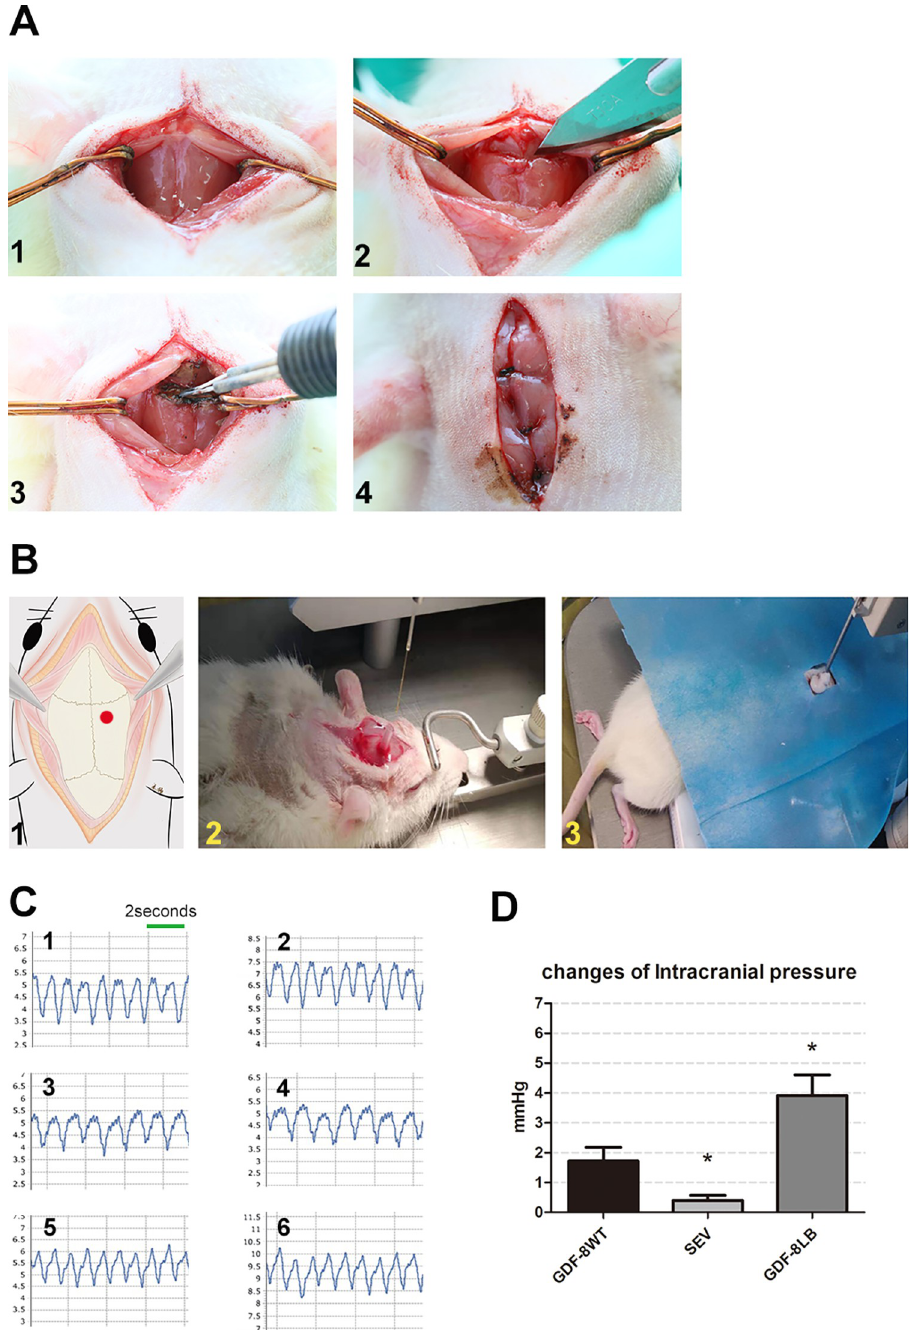
Fig 4. Hyperplasia of the suboccipital muscles significantly increased intracranial pressure. A. 1, a sagittal incision was made on skin and the superficial layer of muscles to expose the RCDma muscles; 2, the RCDma as well as RCDmi muscles were severed near the posterior edge of the occiput; 3, the severed ends of the RCDma and RCDmi muscles were then cauterized; 4, the superficial layer of muscles and skin were sutured at last. B. 1, perforation site is 2mm lateral and 2mm posterior to the bregma; 2, a transparent plastic tube was inserted into the skull opening and a clear dental cement was applied to seal the gap between the boney perforation and the inserted plastic tube; 3, the ICP probe was fixed for measurement and all the gaps were sealed gain with another colored dental polymer. C. 1, representative anesthesia ICP level of saline injection group (GDF8-WT); 2, representative awaken ICP value of saline injection group (GDF-8WT); 3, representative anesthesia ICP level of RCDma and RCDmi muscles severed group (SEV); 4, representative awaken ICP level of RCDma and RCDmi muscles severed group (SEV); 5, representative anesthesia